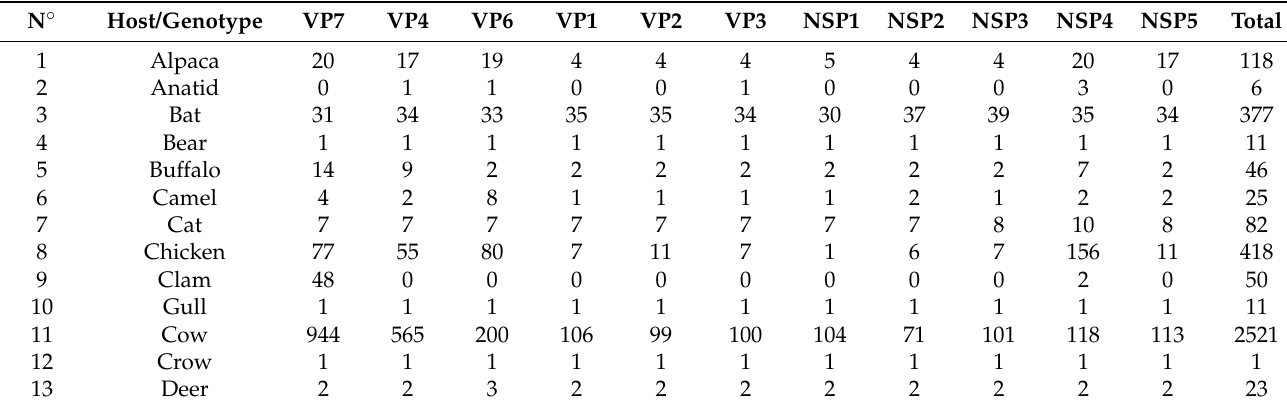
Table A2. Number of genotypes and RVA hosts